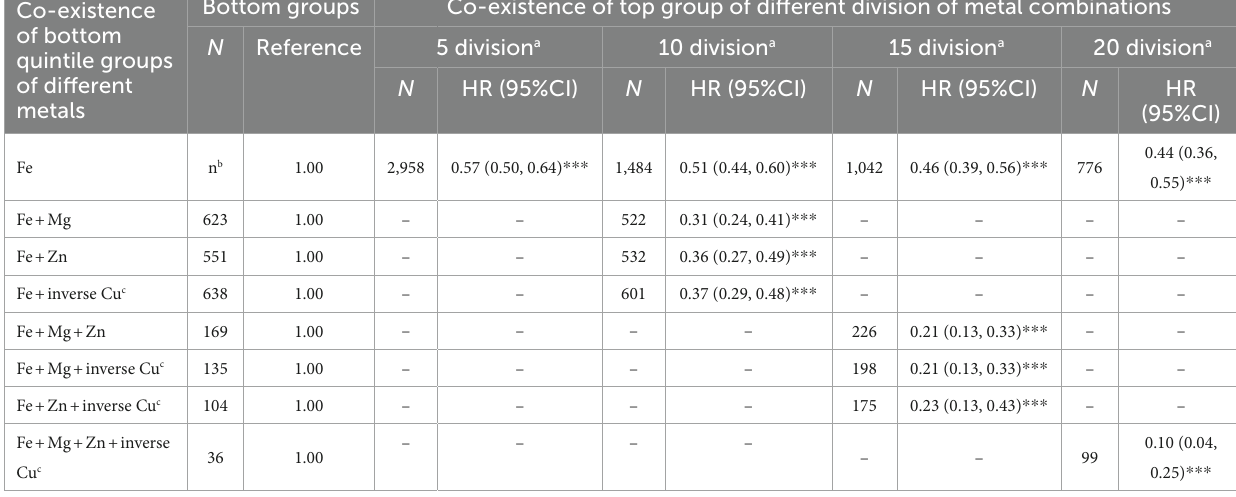
TABLE 4 Cox regression analyses of combination of different metal concentrations and postpartum anemia. Co-existence of